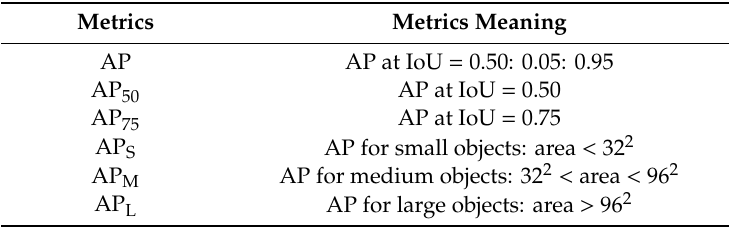
Table 2. COCO Dataset Object Detection Evaluation Metrics